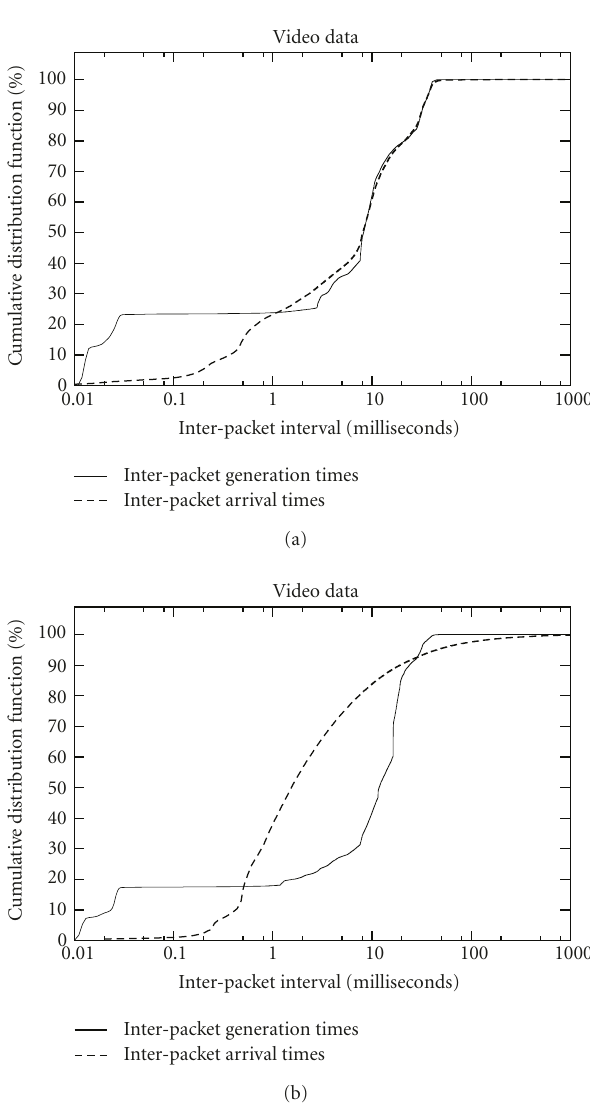
Figure 26: Cumulative distribution function for the interpacket generation interval and interpacket arrival interval in a scenario with one hop (a) and ten hops